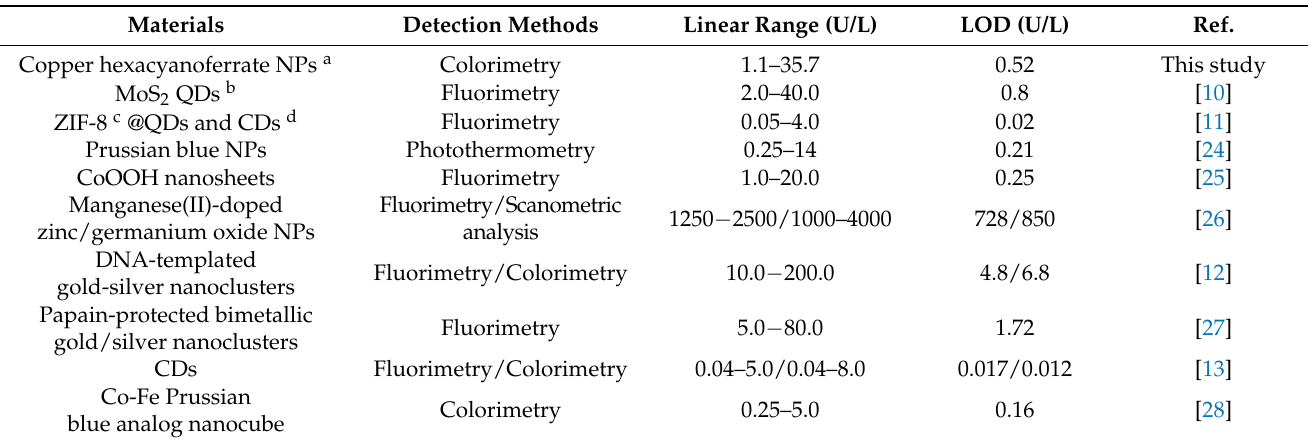
Figure 5. UV–Vis absorption spectra of ABTS system after the addition of different activities of AAO ( A ). The corresponding calibration plots for AAO ( B ) (Insets: the corresponding images). Error bars represent standard deviations ( n = 3). Table 1. Comparisons of the reported methods for the detection of AAO activity.